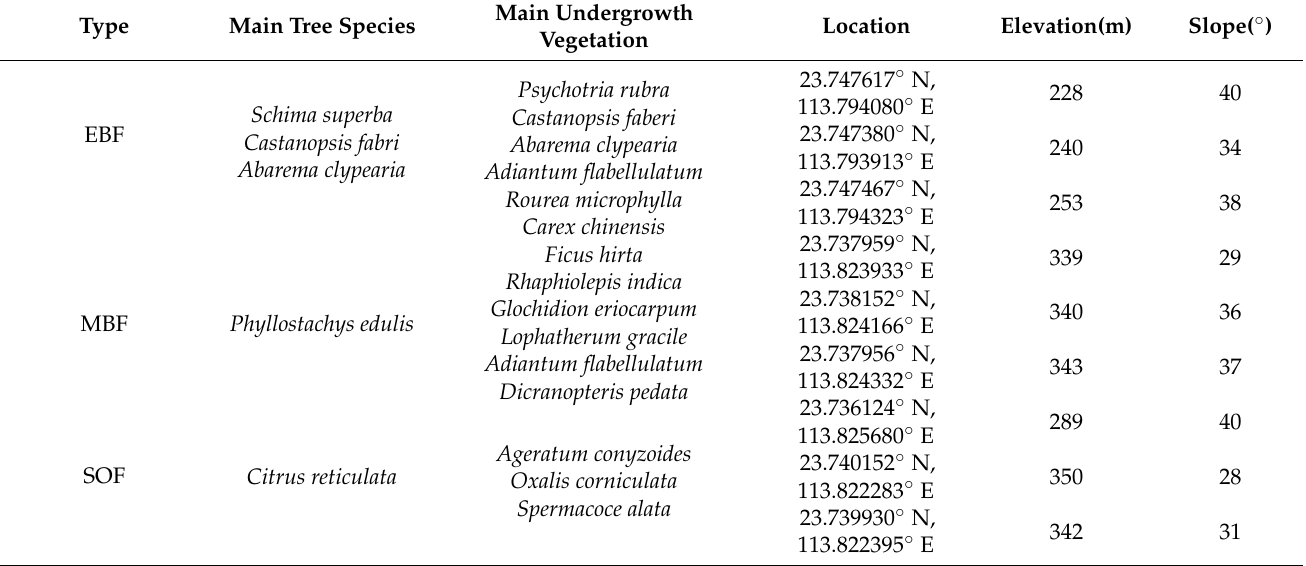
Table 1. Stand information of different